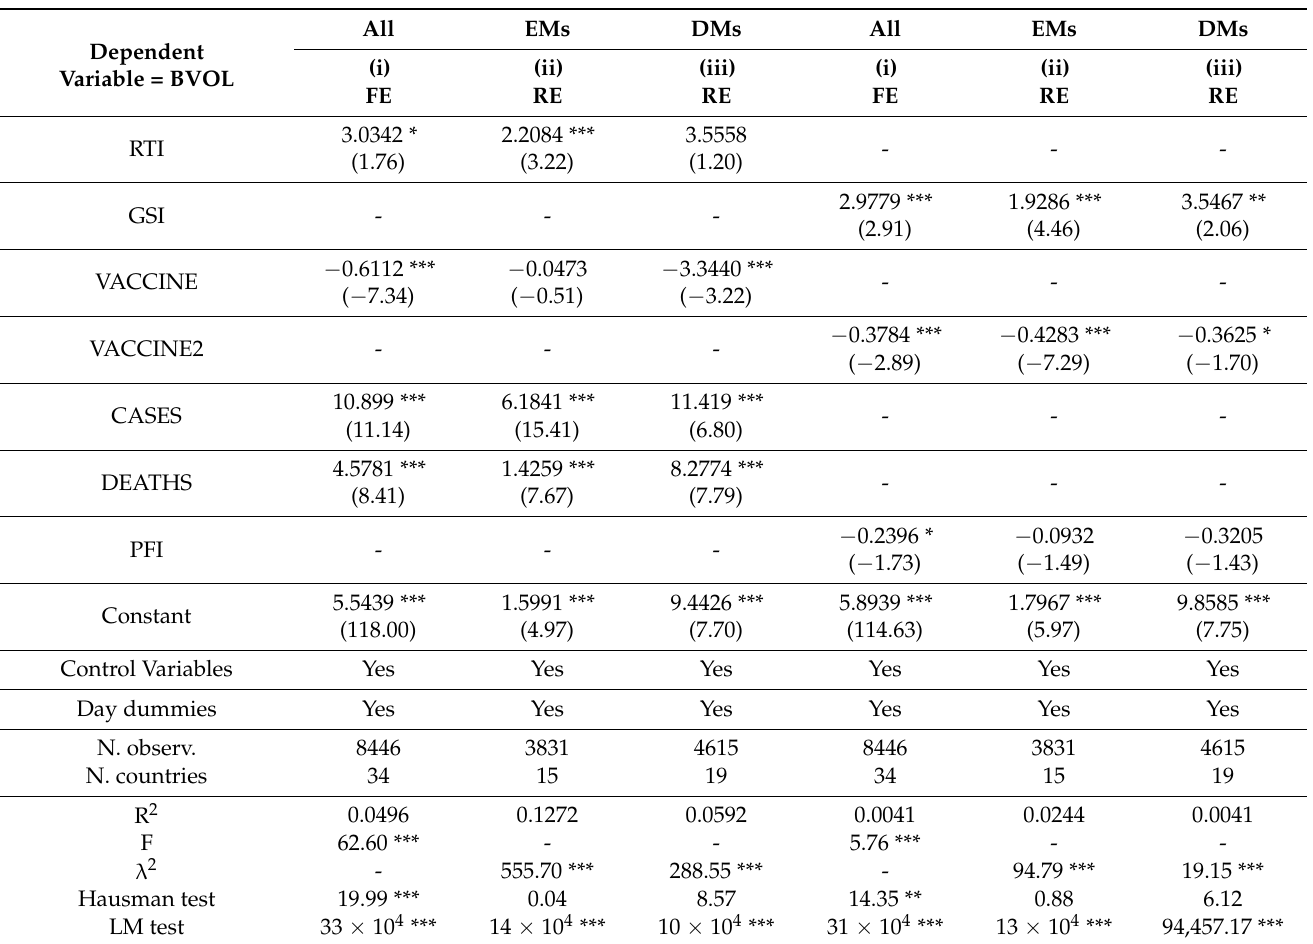
Table 3. Impact of COVID-19 containment measures on bond market volatility during the COVID-19